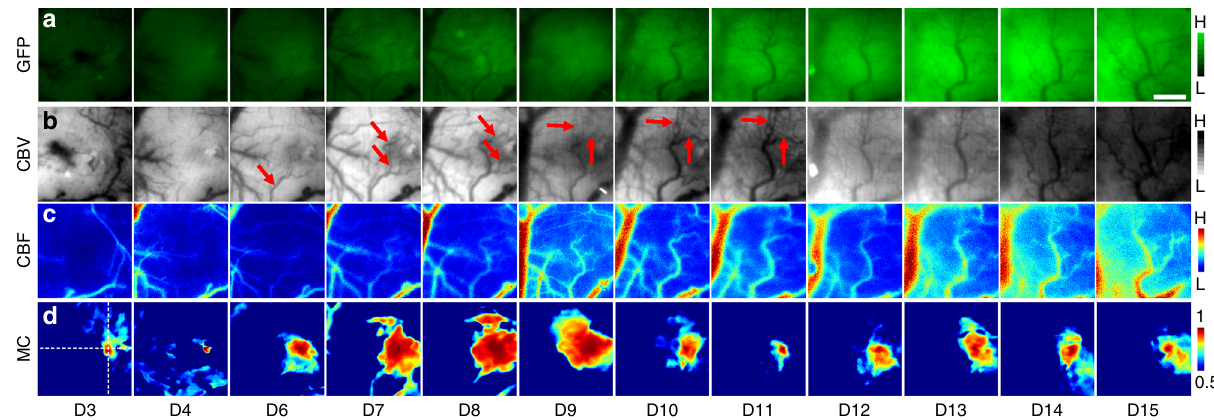
Fig. 6 Life-cycle brain tumor imaging reveals angiogenesis-induced changes. Panels illustrating ( a ) brain tumor progression (GFP), and concomitant changes in ( b ) cerebral blood volume (CBV) and ( c ) cerebral blood fl ow (CBF) due to tumor angiogenesis. d Microvascular connectivity (MC) changes were also mapped in the freely behaving animal over the entire life-cycle (i.e., 16 day period after brain tumor inoculation on D0) of the brain tumor. MC was calculated by correlating CBV fl uctuations from the entire FoV over 5 min with those from the seed pixel indicated by crosshairs. Data presented is from a single animal and scale bar indicates 500 μ